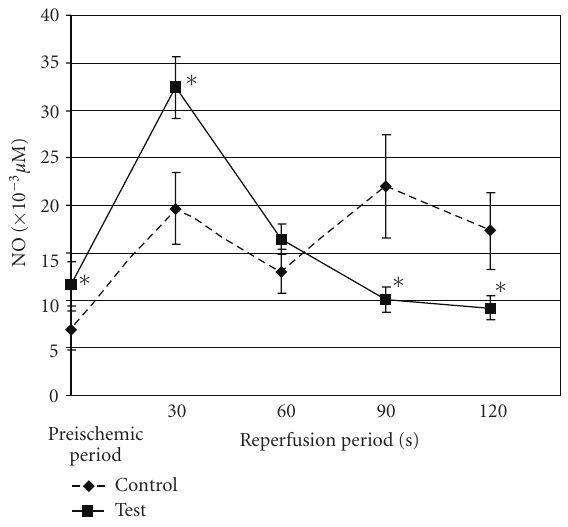
Figure 3: NO concentrations in the coronary venous e ffl uent collected during preischemic and reperfusion period in the control and test groups. ∗ represents significantly di ff erent values between corresponding values in control and test groups, P < . 01; n =